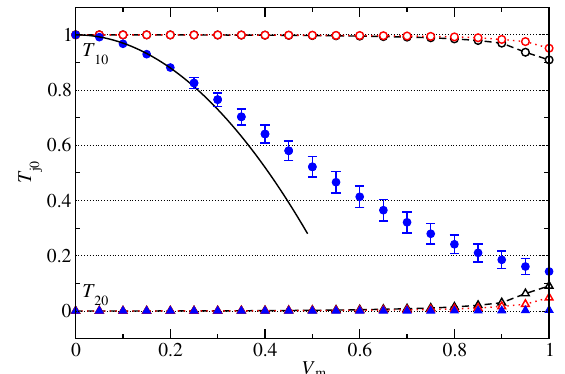
FIG. 4. Effect of very strong disorder on the QSH phase in the four-terminal (cid:3) -shape geometry. We plot the dimensionless differential conductance from lead 0 to leads 1 and 2 as a ¼ 0 : 02 , l B ’ 8 , E ¼ function of disorder strength for (cid:1) so F 0 : 05 , and otherwise the same system as in Fig. 3. Circular and triangular symbols for T . The symbols stand for T 10 20 (not shown) is the same as for T . Dashed behavior for T 30 10 ), dotted (red) black lines correspond to purely scalar disorder ( V s ), and filled lines correspond to purely Zeeman-like disorder ( V z nonconserving disorder blue symbols correspond to purely S z ). The latter is clearly the dominant effect on T , although ( V m 10 unrealistically large values are required to quantitatively affect the edge-state transmission. (See main text for a mean-free-path estimate.) Each data point has been averaged over 48 disorder configurations. Unless shown, error bars are smaller than symbol sizes. Full black line: fit y ¼ 1 (cid:2) 3 : 0 x 2